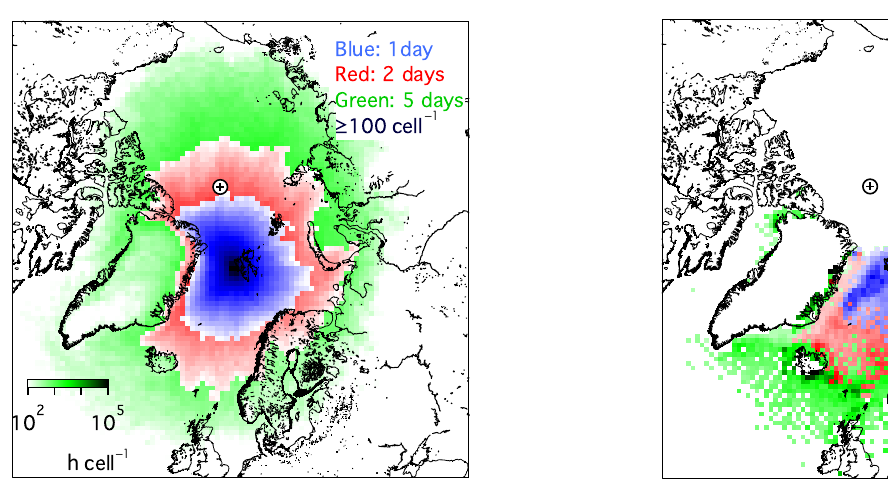
Figure 1. Map of the regional distribution of 5-day (green), 2-day (red), and 1-day (blue) hourly back trajectories to Mt. Zeppelin dur- ing the months March through October of the years 2006–2015. Black cross in a circle: North Pole. The colored areas are covered with at least 100 trajectory hours per geocell and the color satura- tion corresponds to the number of trajectory hours per grid cell on a log scale.